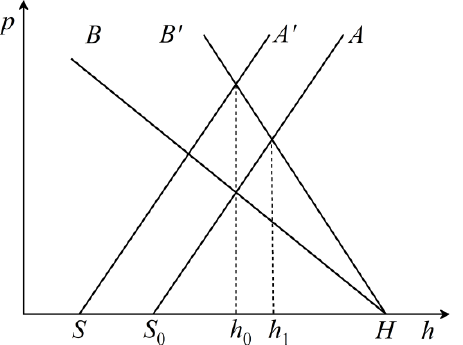
Figure 5. Adjustment reduction principle under the influence of deformation resistance.